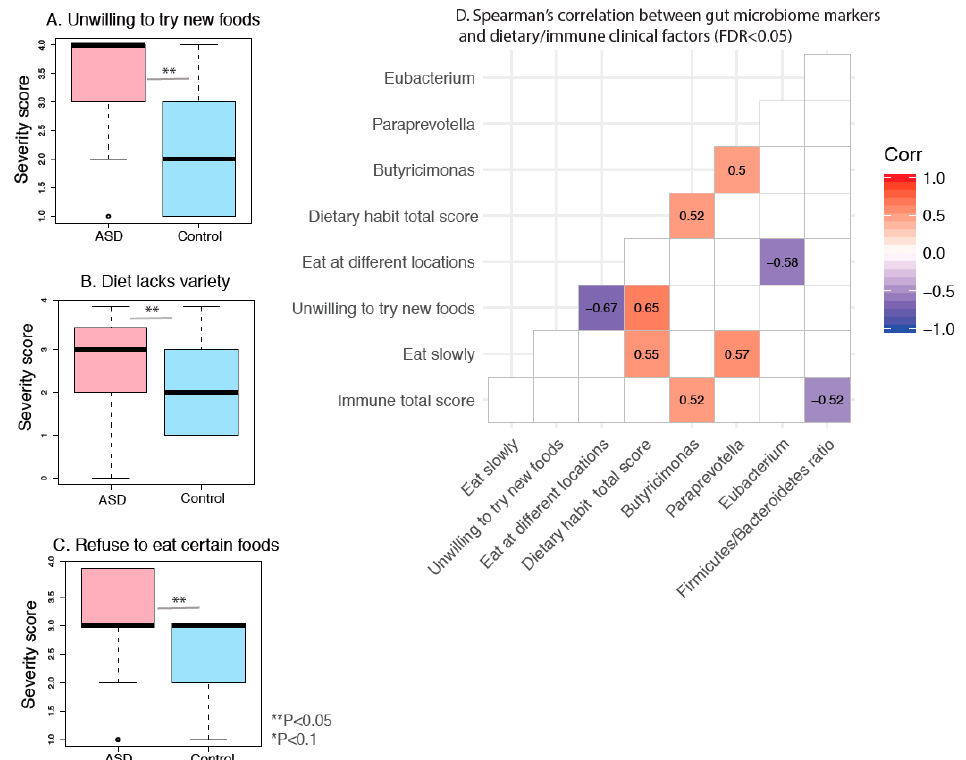
Figure 8. Box plot representation of abnormal dietary habit severity scores in ASD and control subjects. ( A ) Unwilling to try new foods. ( B ) Diet lacks variety. ( C ) Refuse to eat certain foods. Single asterisk indicates p < 0.1; double asterisk indicates p < 0.05, Mann–Whitney U test. ( D ) Spearman’s correlation matrix between habit scores, allergy / autoimmunity scores, gastrointestinal severity indices (GSI) total score, and selected ASD gut microbiome markers in patients with ASD (results with FDR < 0.05 were shown).